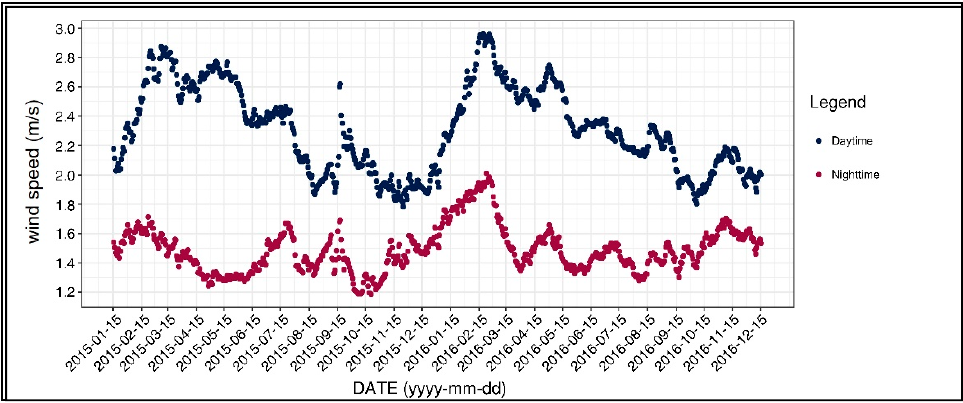
Figure 3. Wind speed of the 31-day moving average.